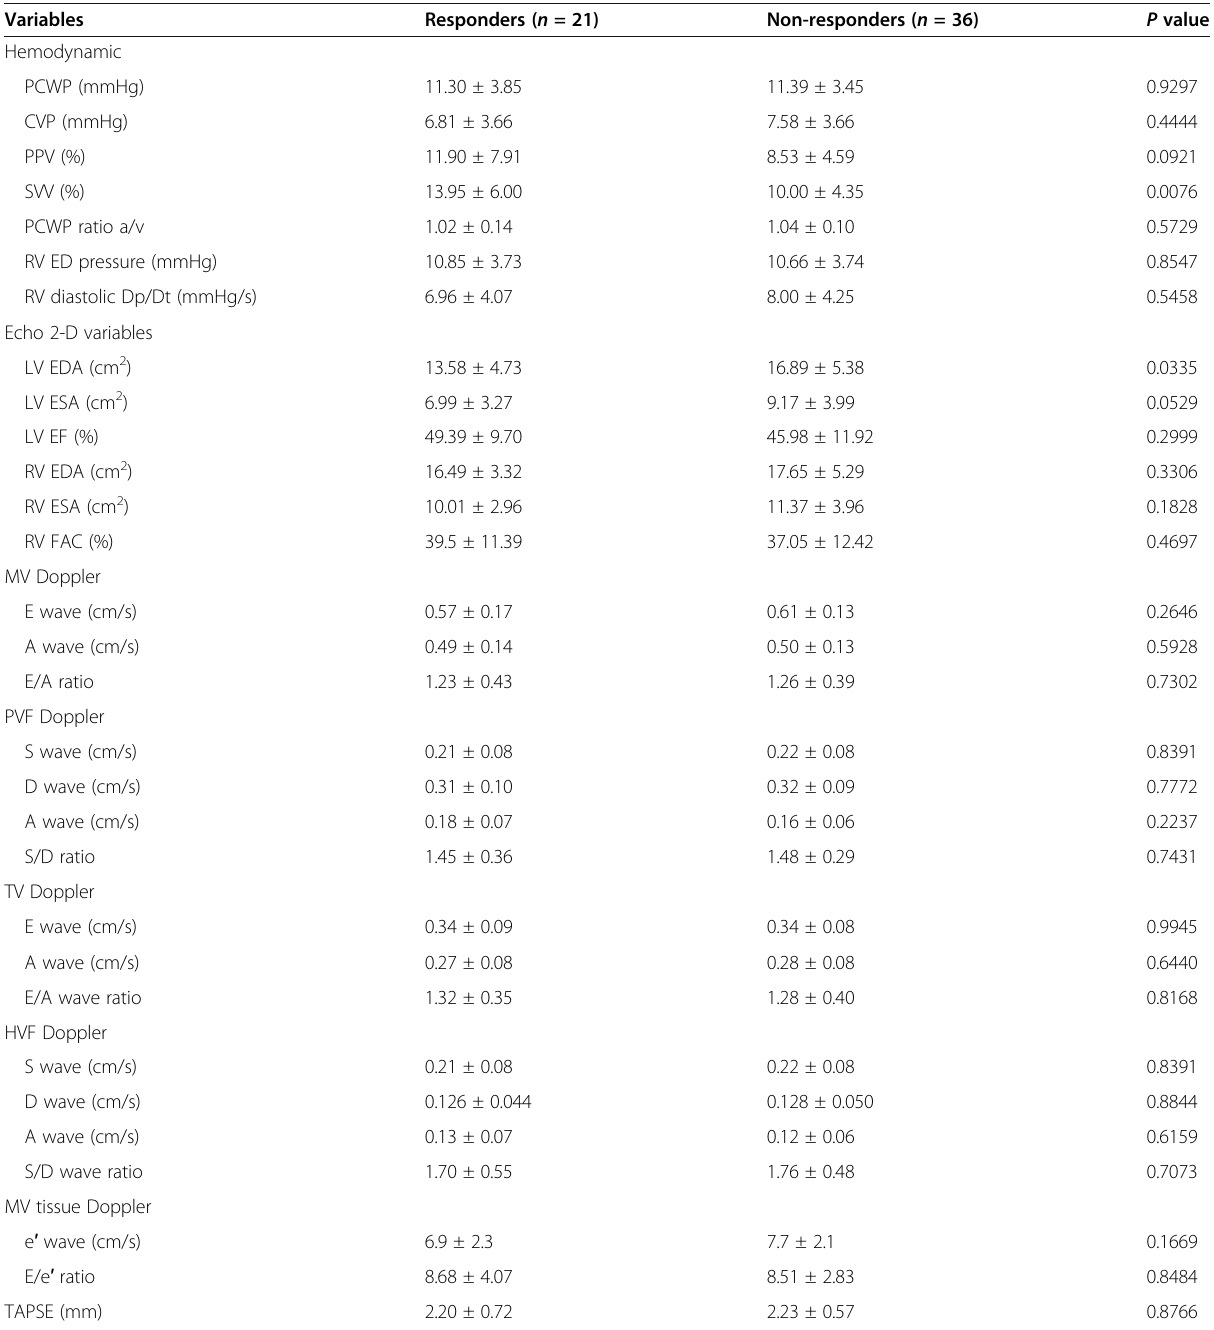
Table 2 Hemodynamic, two-dimensional, pulsed wave, and tissue Doppler echocardiographic data for the responders and non- responders